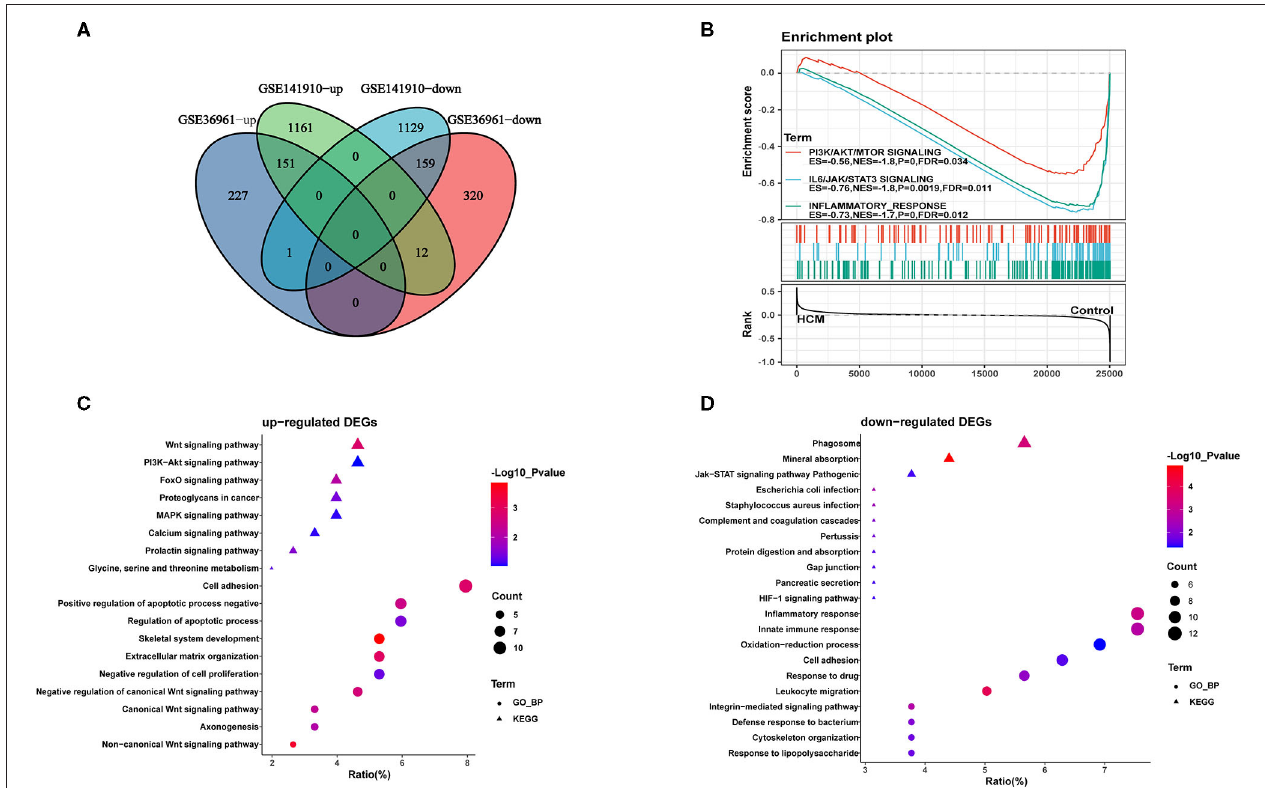
FIGURE 3 | Identification and functional annotations of DEGs. (A) Venn diagram of up- and downregulated DEGs in GSE36961 and GSE141910 datasets. (B) GSEA for significantly enriched pathways in GSE36961. (C,D) GO and KEGG functional enrichment of up- and downregulated DEGs in HCM and healthy control cardiac